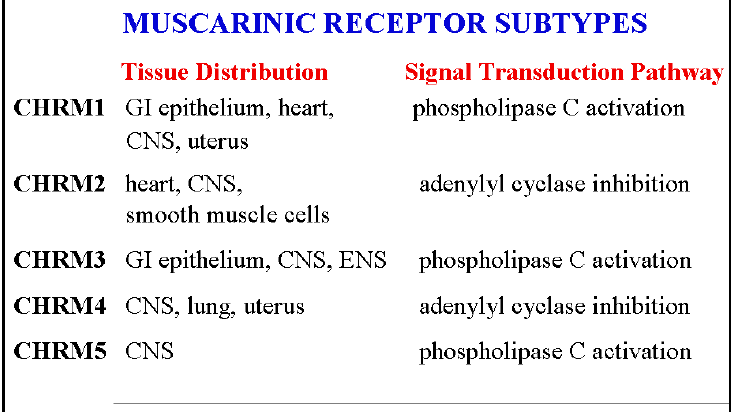
Figure 1. Tissue distribution and signal transduction pathways of the five muscarinic receptor